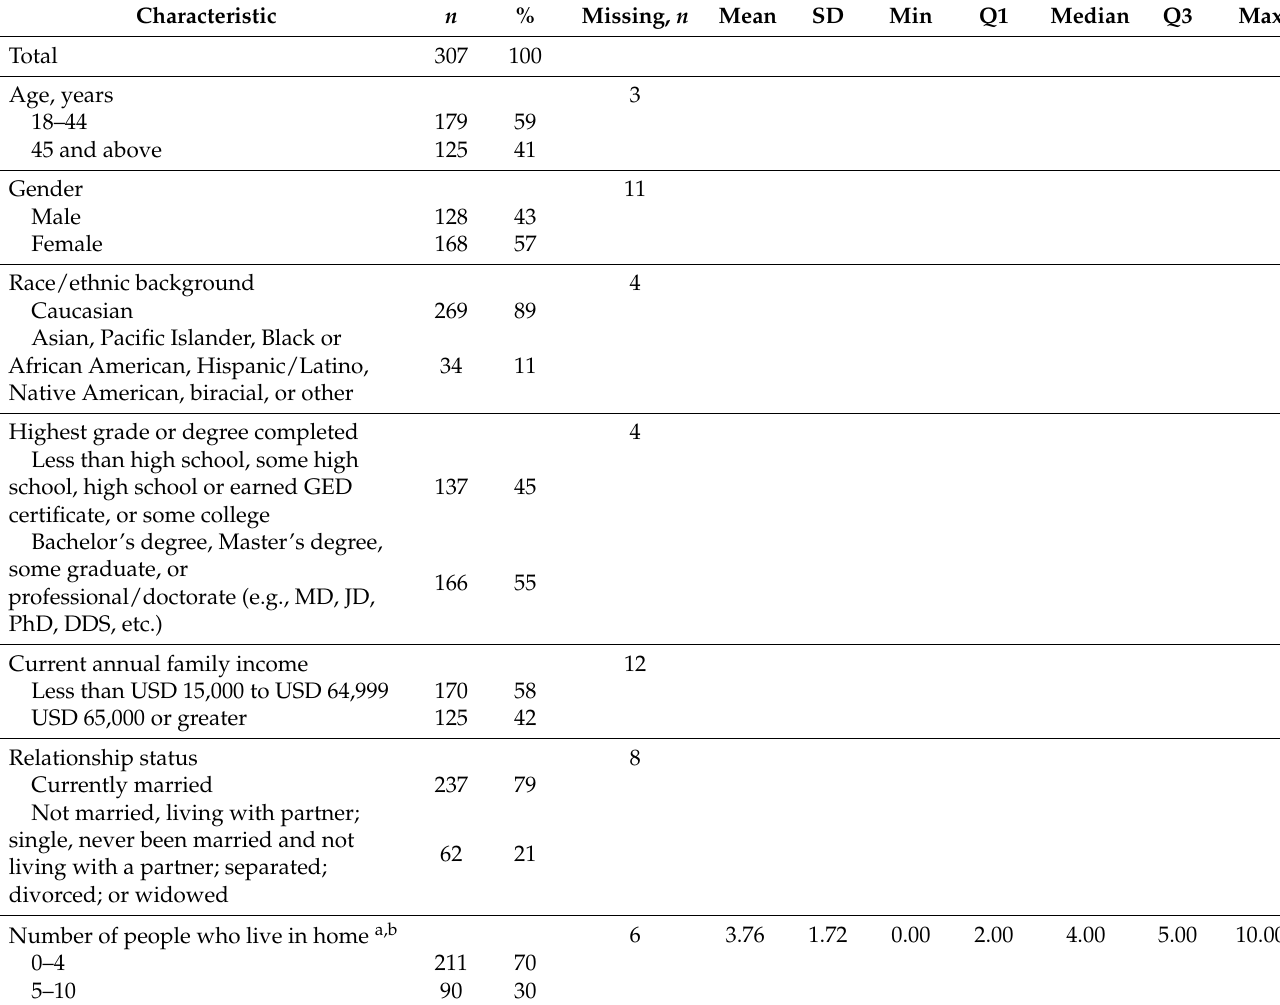
Table 1. Characteristics of radon testing survey participants, Utah County, Utah, May 2014–January